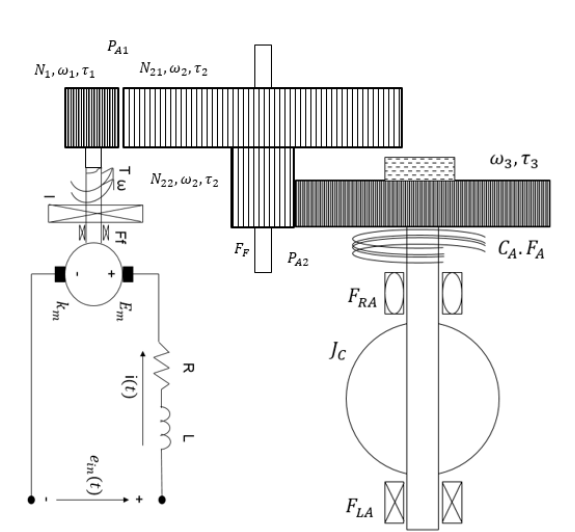
Figure 3. Schematic representation of the ACV actuator Figure 2. Section through the ACV actuator